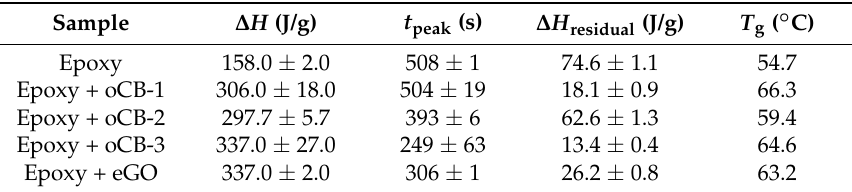
Figure 6. Isothermal DSC scans at 50 °C of the DGEBA-IPDA epoxy resin. The lowest curve ( green ) corresponds to the neat epoxy resin. The other curves correspond to the epoxy resin filled by 3 wt % of different nanofillers: oCB-1 (O/C, wt/wt = 0.16) ( blue ); oCB-2 (O/C, wt/wt = 0.83) ( wine ) oCB-3 (O/C, wt/wt = 0.91) ( black ); eGO (O/C, wt/wt = 0.62) ( orange ). Table 4. Enthalpy, normalized with respect to the resin weight ( ∆ H ) and peak time ( t peak ) obtained by isothermal DSC scans at 50 °C, for the neat epoxy resin and the epoxy resin with different graphite-based nanofillers.